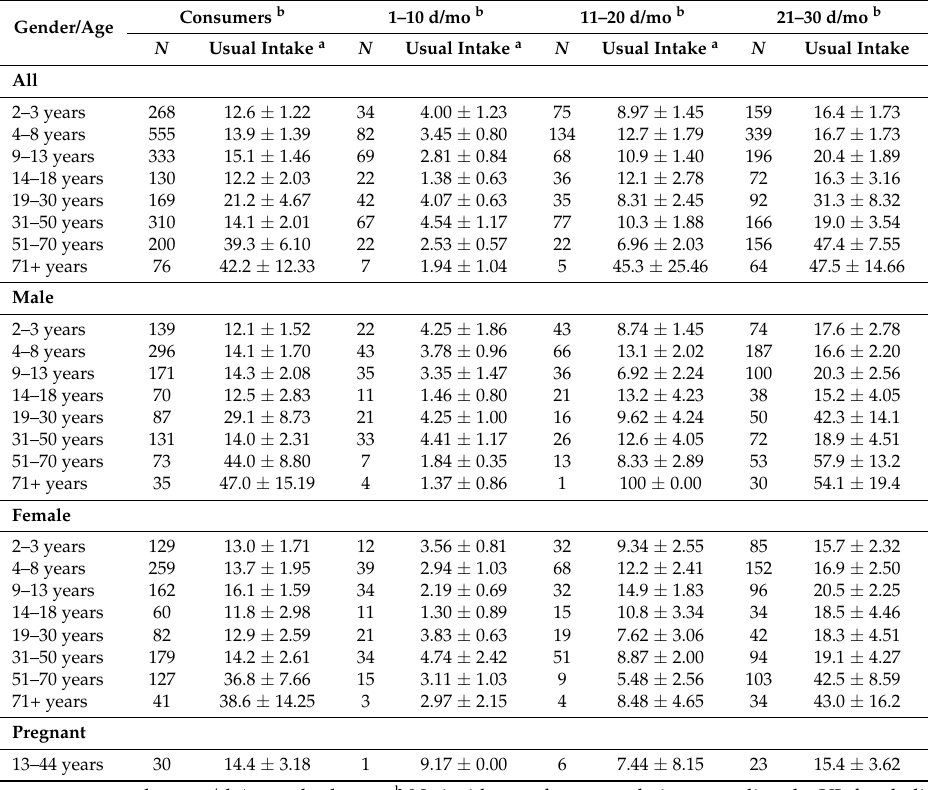
Table 6. Contribution of dietary supplements by frequency to total usual choline